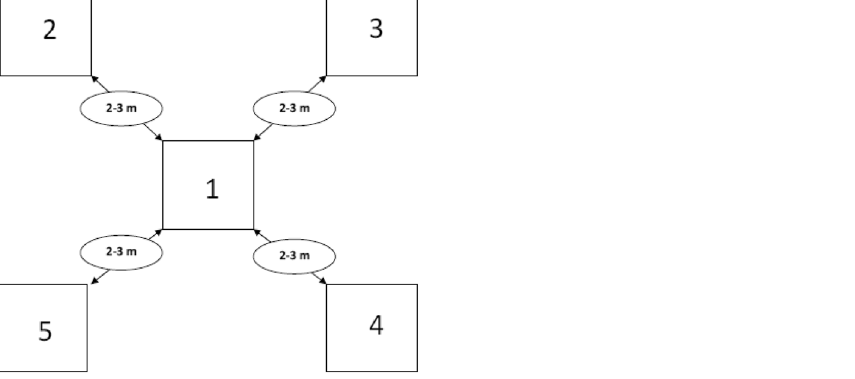
Figure 1. Sampling schedule elaborated for cryptic species of A. pinguis and soil materials (Authors).